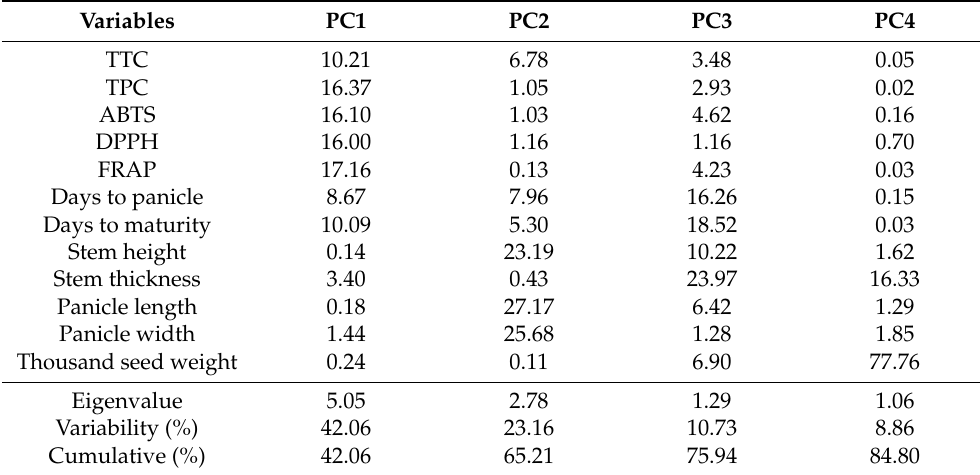
Table 4. Contributions of variables in the first four principal